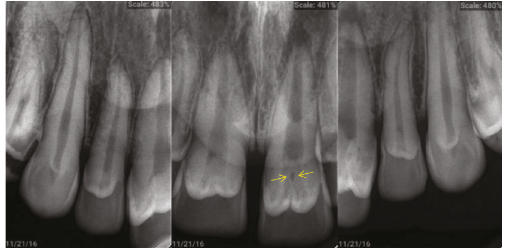
Figure 5: Case 1: periapical radiograph shows talon cusps in all upper anterior teeth. Notice the small radiolucent teardrop in the centre of the crown of the left central incisor (dens invaginatus).